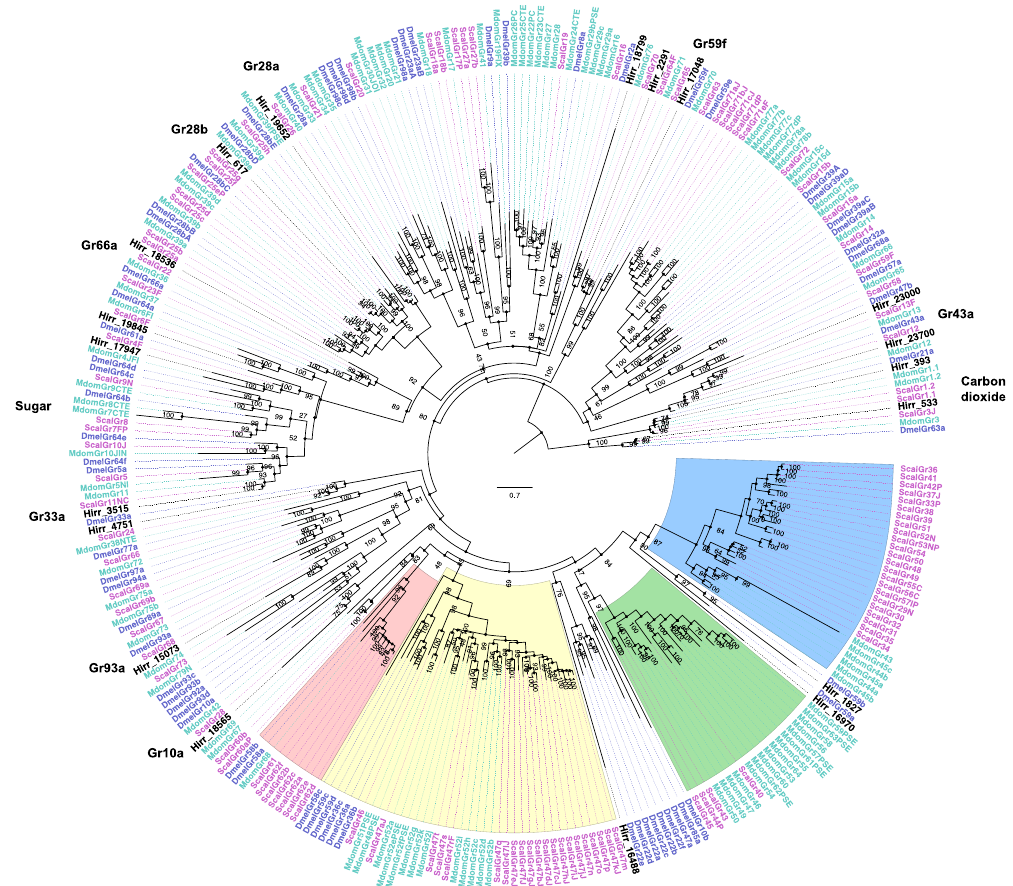
Figure 8. Phylogenetic relationship of Haematobia irritans candidate gustatory receptors (GR) with those of Stomoxys calcitrans , Musca domestica, and Drosophila melanogaster . The H. irritans (Hirr) genes are labeled in black, while the S. calcitrans (Scal) and M. domestica (Mdom) genes are labeled in pink and teal, respectively. D. melanogaster (Dmel) genes are labeled in purple. Shaded regions identify four different bitter taste receptor clades that are expanded in S. calcitrans and M. domestica , as described in [44] . The color pattern of clades used in [44] is reflected here. Individual Drosophila genes are labeled on the edge to assist with finding them in the tree.